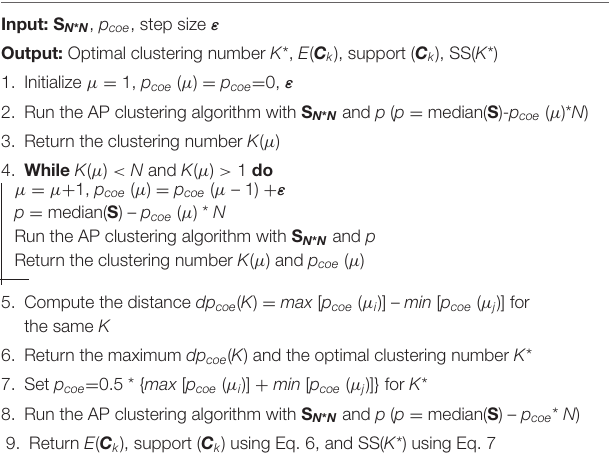
Algorithm 2 | Patient clustering algorithm.